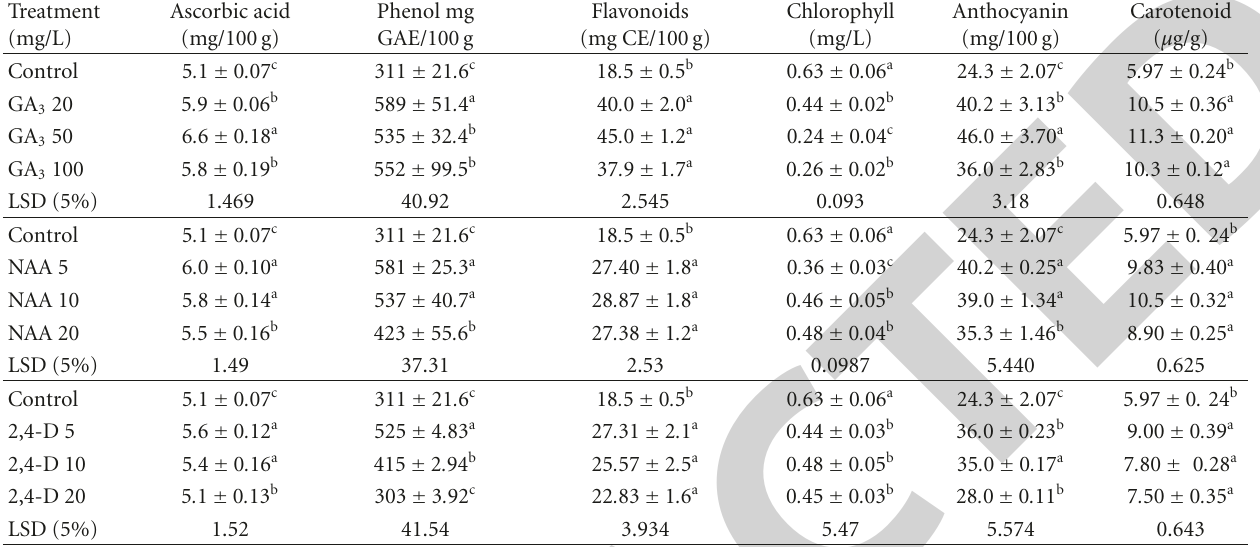
Table 3: E ff ect of growth regulators on phytochemical properties and pigmentation of wax apple fruits.